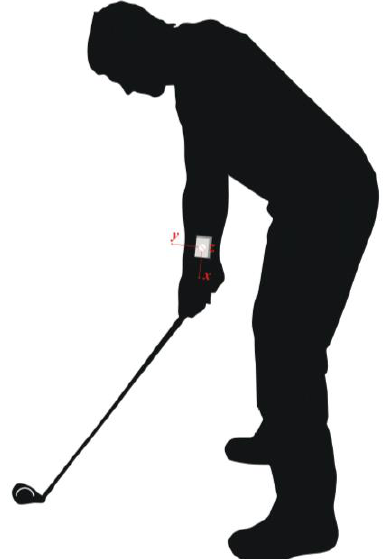
Figure 1. Position of the measurement sensor on the right-handed golfer’s leading arm during the golf ball